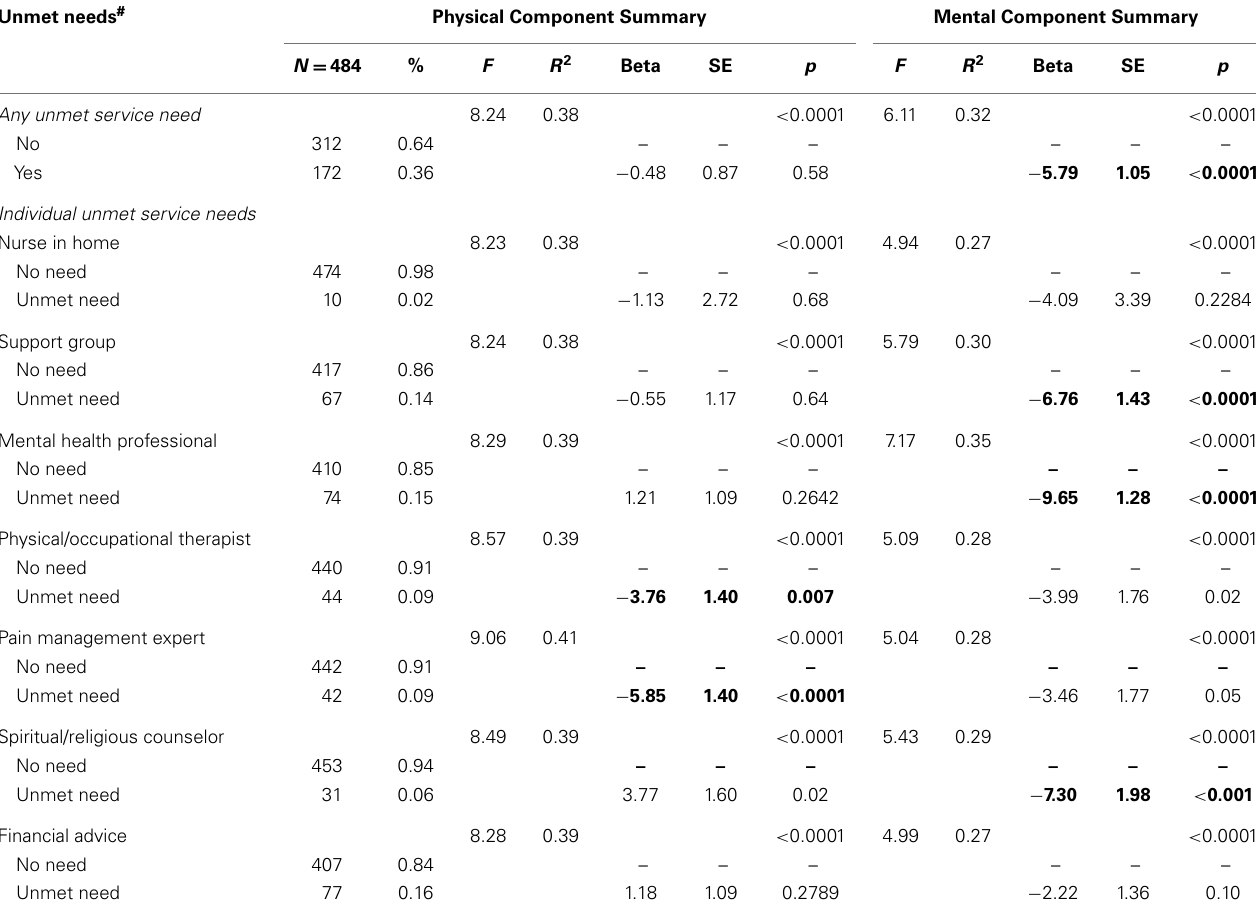
Table 3 | Multiple linear regression models* examining unmet service needs and SF-12 health-related quality of life summary